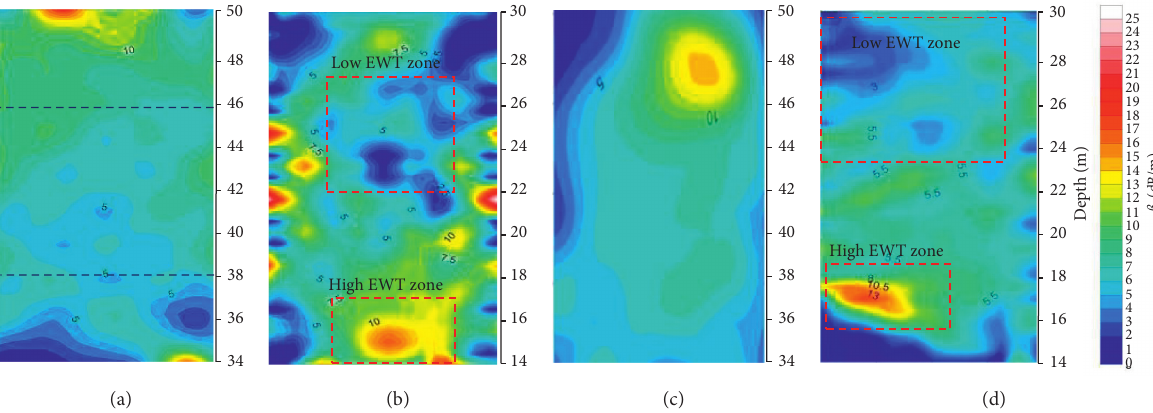
Figure 10: Electromagnetic CT image of station II and station III. (a) No. 2 cross-hole. (b) No. 3 cross-hole. (c) No. 4 cross-hole. (d) No. 5